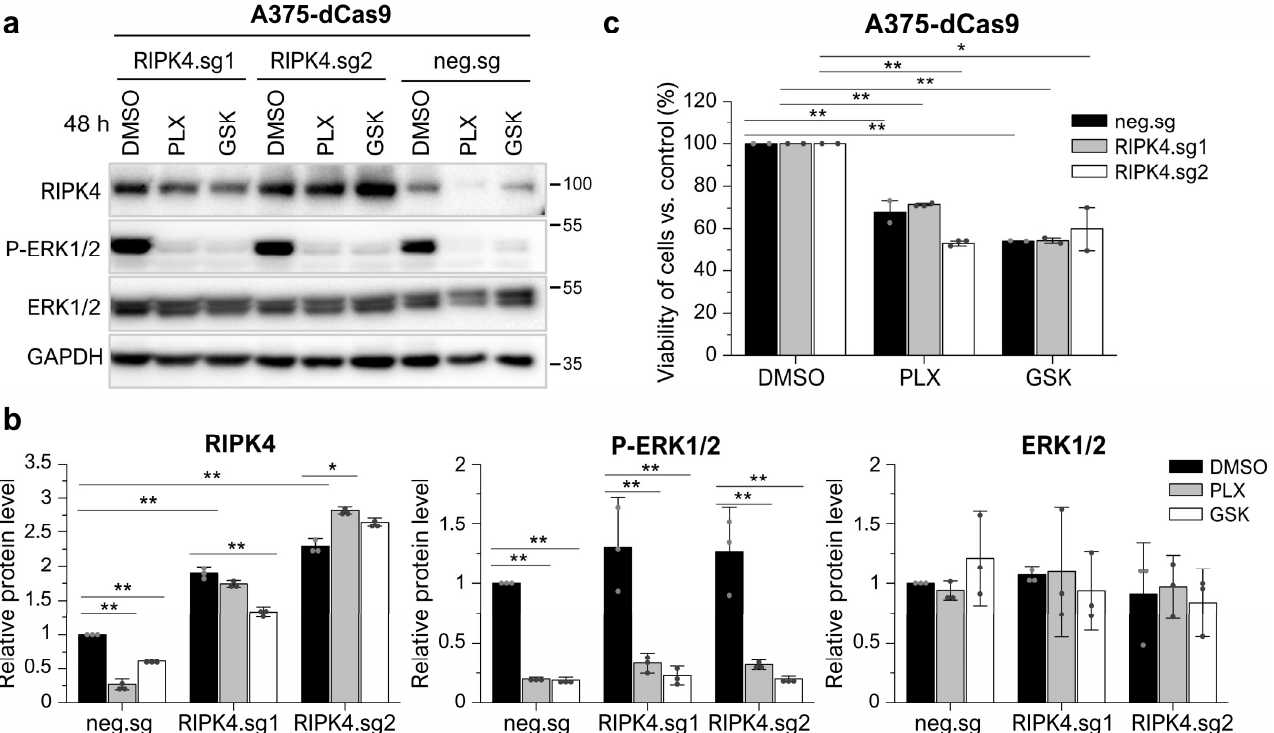
Figure 4. RIPK4 overexpression in A375-dCas9 cells inhibits the RIPK4 diminishing effect of BRAFi but do not affect ERK1/2 activity. A375-dCas9 cells are transfected with two single sgRNAs targeting RIPK4 (RIPK4.sg1, RIPK4.sg2) or no targeting control (neg.sg). After 72 h of transfection, cells were incubated with vemurafenib (PLX; 10 µM) and dabrafenib (GSK; 10 nM), or DMSO, as a control, for 48 h. ( a , b ) The expression levels of RIPK4, P-ERK1/2, and ERK1/2 were analyzed using Western blot along with densitometry. GAPDH was used as a loading control. ( c ) MTT assay after 24 h. Each bar represents the mean ± SD of three biological replicates. * p < 0.05 and ** p < 0.01 were considered significant.